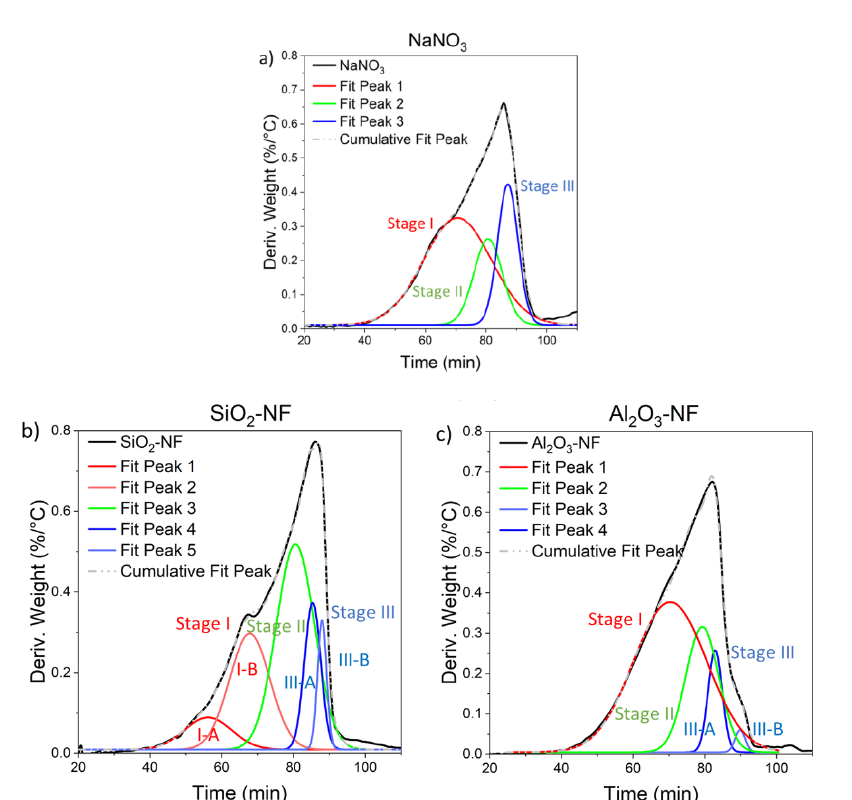
Figure 9. Non-linear peak deconvolution fit of the TGA weight derivative over time for ( a ) NaNO 3 , ( b ) NaNO 3 /SiO 2 NF (1% wt.) and ( c ) NaNO 3 /Al 2 O 3 NF (1% wt.).